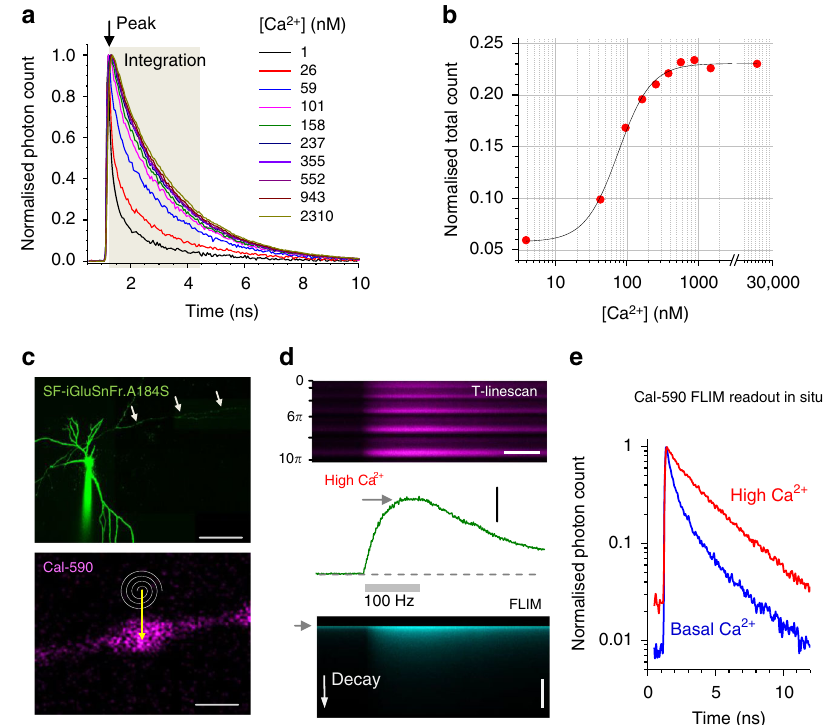
Fig. 1 Fluorescence lifetime of Cal-590 provides readout of low intracellular Ca 2 + . a Fluorescence lifetime decay curves of Cal-590 in a series of calibrated [Ca 2 + ]-clamped solutions fi nely adjusted to include appropriate intracellular ingredients 13,14 (Methods). Fluorescence lifetime traces are normalised to their peak values (at ~1.3 ns post-pulse); the area under the curve over the time interval of 3 ns (tan shade) was measured and related to the peak value thus providing normalised total count (NTC) readout; λ x 2p = 910 nm; temperature 33 °C. b The Cal-590 fl uorescence lifetime imaging microscopy (FLIM) [Ca 2 + ] sensitivity estimator, NTC, fi tted with sigmoid-type function ( χ 2 = 2.11 × 10 − 5 , R 2 = 0.996). c Top: Example of a CA3 pyramidal cell (SF-iGluSnFR channel); arrowheads, proximal part of the traced axon; patch pipette is seen. Bottom: Example of an axonal bouton (Cal-590 channel) traced from the cell soma; spiral line and arrow, tornado linescan applied in the middle of the bouton; scale bar, 50 µ m (top) and 1 µ m (bottom). d Example of a single-bouton Cal-590 signal during a 500-ms 100-Hz burst of spike-inducing somatic 1 ms current pulses: recorded as a tornado linescan (top; ordinate, spiral rotation angle 0 – 10 π re fl ects fi ve concentric spiral circles, 2 π radian/360° each), fl uorescence intensity (integrated over the 10 π spiral scan) time course (middle), and fl uorescence decay (FLIM, bottom; ordinate, decay time; grey arrowhead, laser pulse onset). Scale bars, 300 ms (top, horizontal), 2.0 Δ F/F (middle, vertical), 5 ns (bottom, vertical). e Intra-bouton Cal-590 fl uorescence decay time course (normalised to peak) representing basal [Ca 2 + ] (blue) and peak [Ca 2 + ] (red), in the experiment shown in